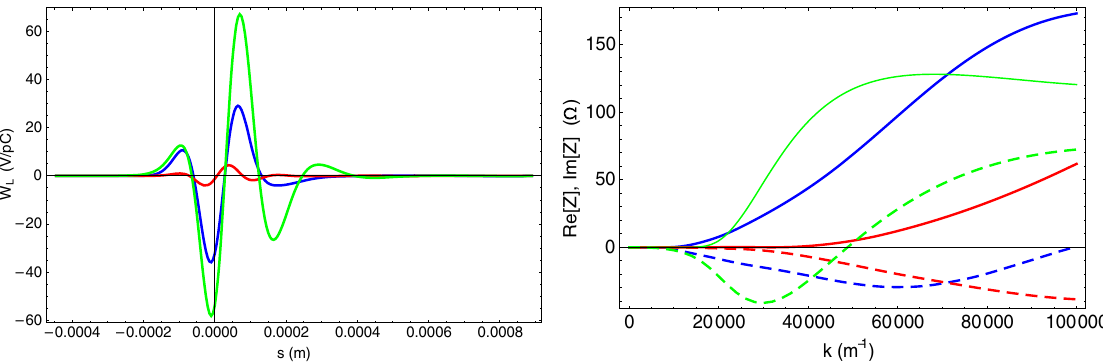
FIG. 2. CSR wakefield for a Gaussian bunch with 50 micron bunch length (left) and impedance (right) for a 4-m long arc dipole with ρ ¼ 744 m computed by the code CSRZ [24] for a square beam pipe with 2 cm (blue) or 1 cm full aperture (red) in the horizontal and vertical direction, compared with the CSR wake and impedance calculated for a simple parallel plate model with a vertical gap of 2 cm (green). In the right picture, solid lines refer to the real part, dashed lines to the imaginary part of the